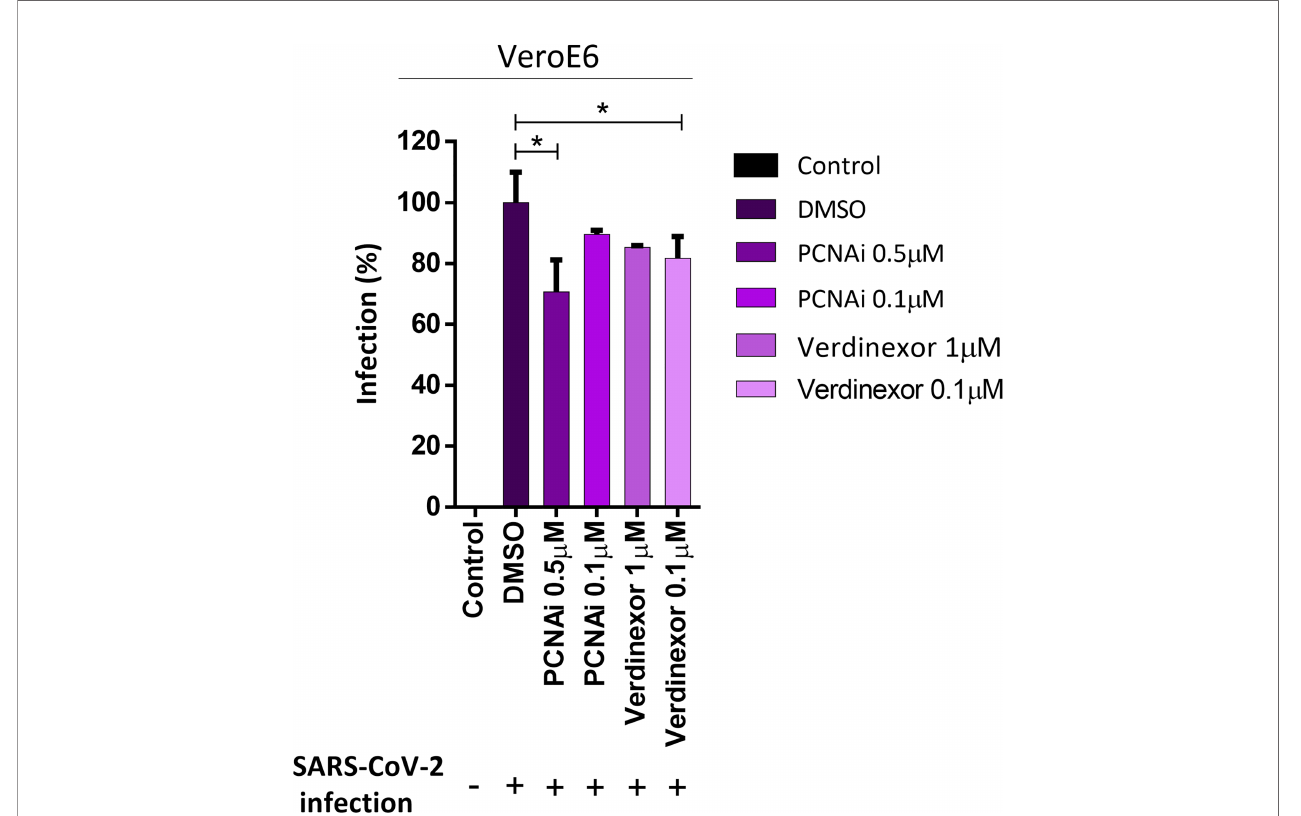
FIGURE 6 | PCNA I1 and Verdinexor inhibit SARS-CoV-2 viral replication in vitro . Vero E6 cells were infected with SARS-CoV-2 as described in the anti-viral in vitro ef fi cacy assay (see Methods), for one hour, then DMSO, PCNA I1 0.5 and 0.1 µM or Verdinexor 1 and 0.1 µM were added to overlay media one hour after virus adsorption. The viral load was assessed by plaque assay after four days of incubation. This data is representative of two independent experiments. T-test was used for independent comparisons between DMSO versus PCNA I1, and DMSO versus Verdinexor. *p < 0.05 were considered statistically signi fi